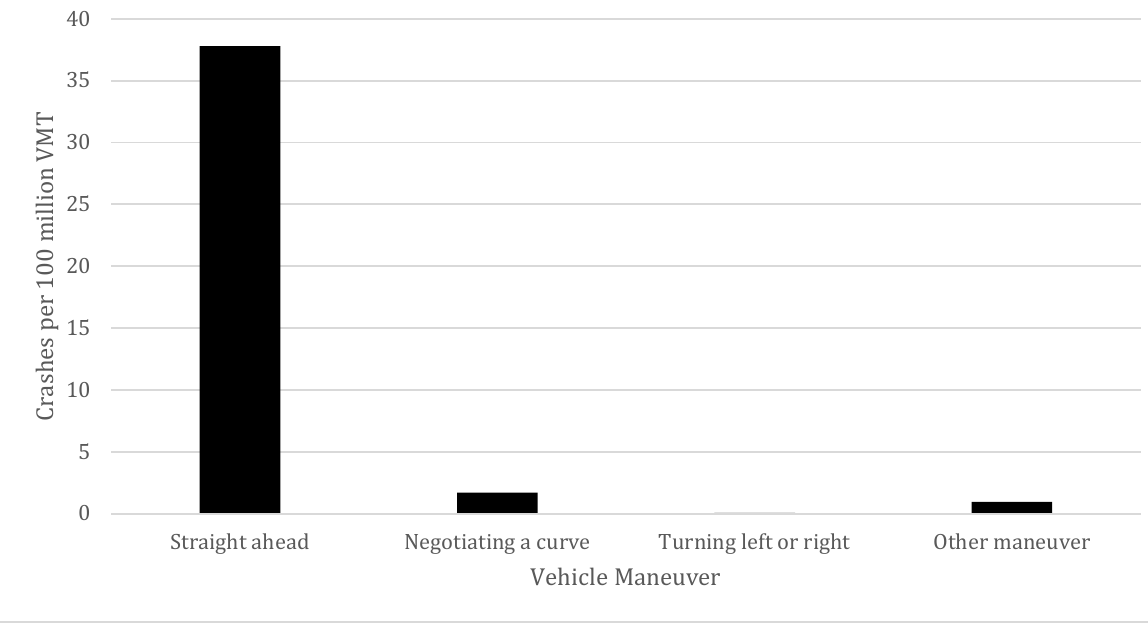
Figure 6 (b): Percentage of animal and non-animal crashes based on vehicle maneuver